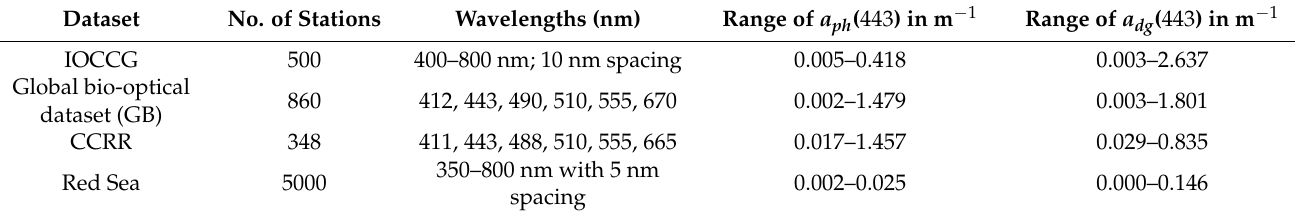
Table 2. Datasets used in the study with available wavelengths and ranges of absorption due to phytoplankton at 443 nm (cid:16) (cid:17) a ph ( 443 ) and coloured detrital matter